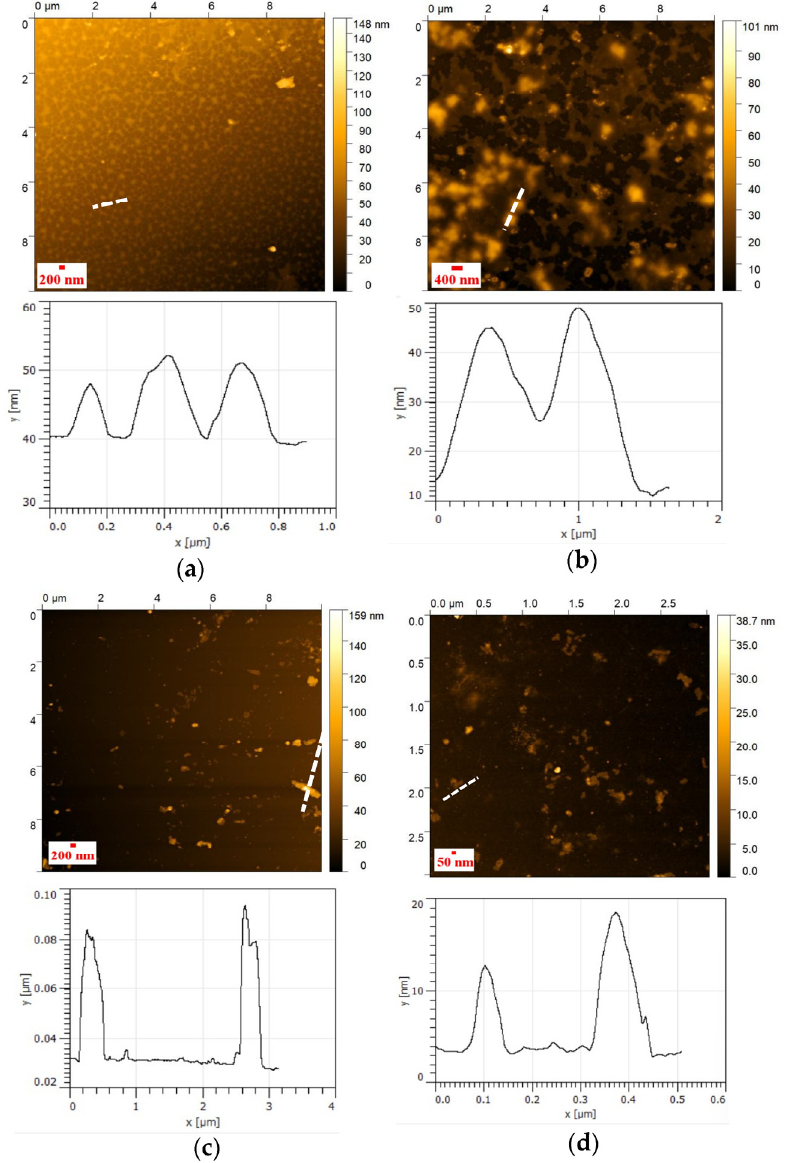
Figure 6. AFM topography images of the DNA and polyplexes (( a )—Only pDNA-GFP (0.5 µg), ( b )—400nm polyplexes, ( c )—200nm polyplexes and ( d )—50nm polyplexes). 10 µg of NHG’s and 0.5 µg DNA were used to prepare the polyplex complexes.